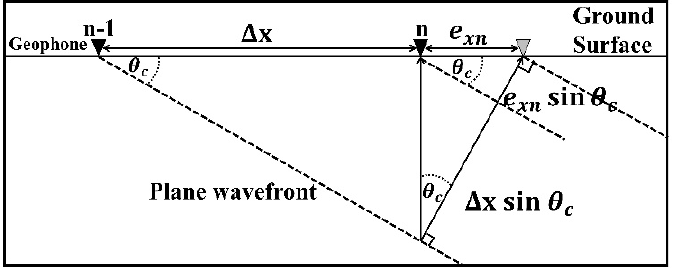
Figure 1. Illustration of error in receiver positions. Black and gray triangles indicate ideal and actual positions of the n th receiver, respectively.